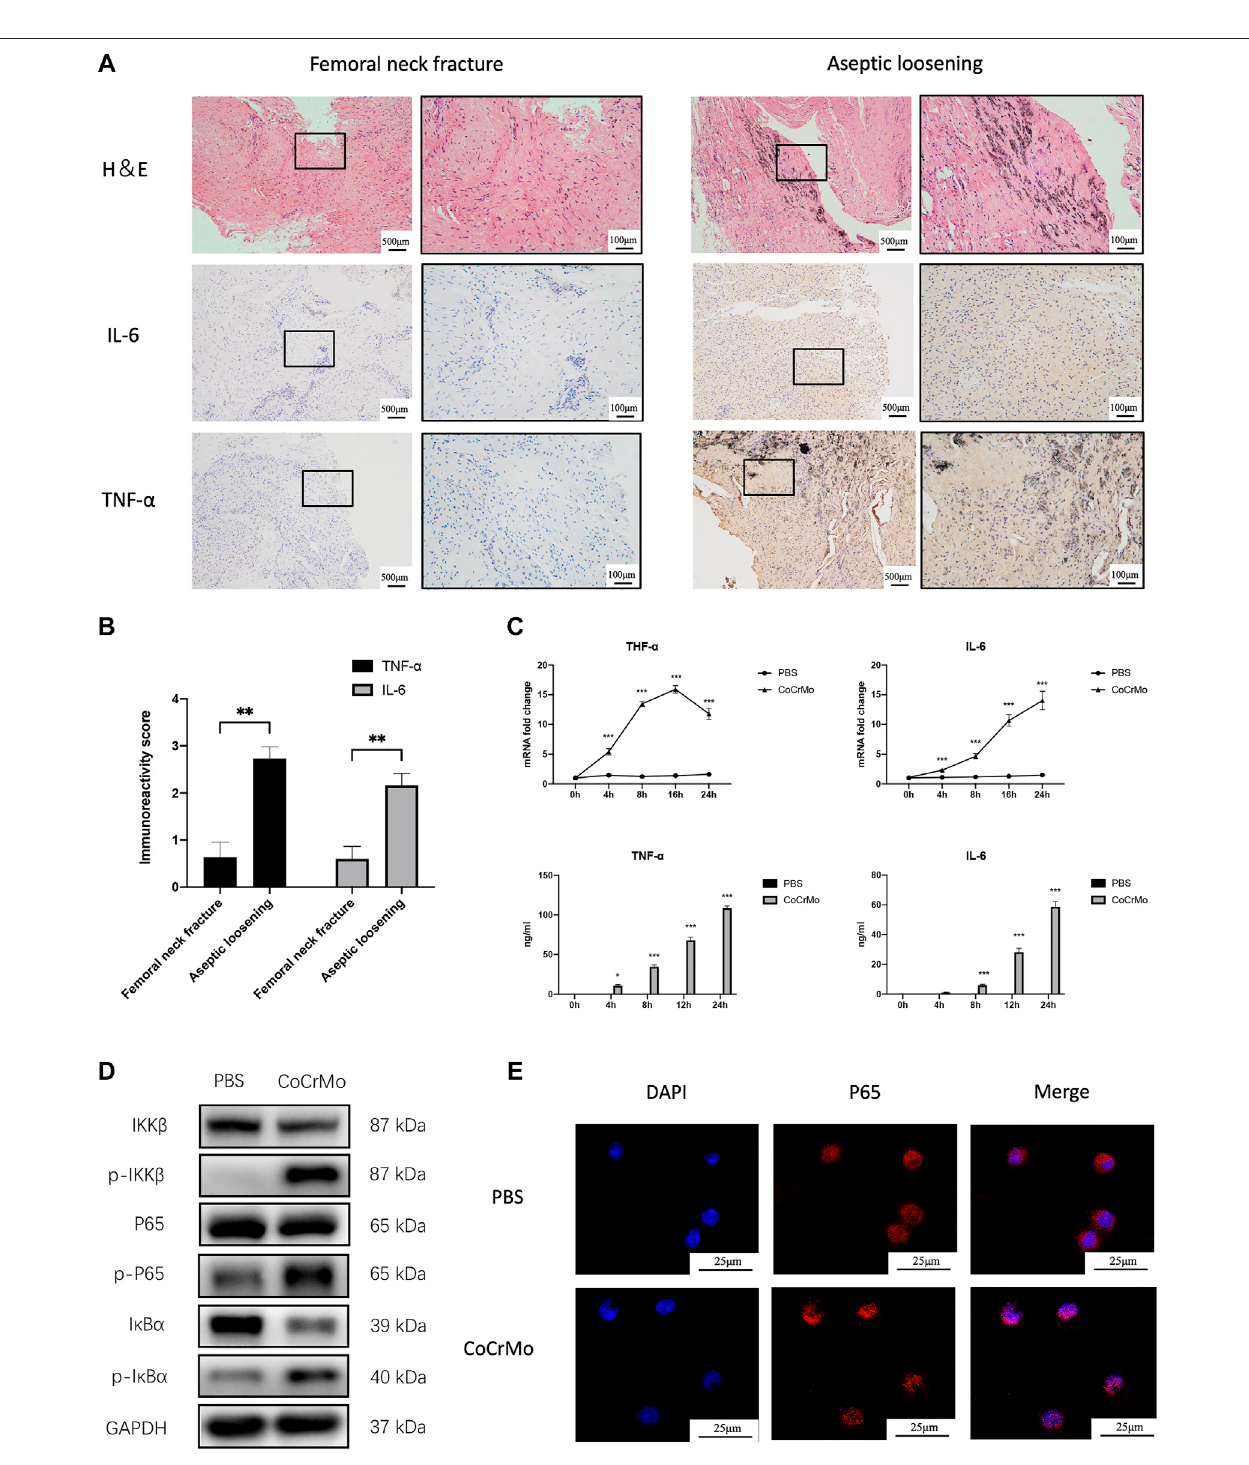
FIGURE2| CoCrMowearparticlesinducedTNF- α andIL-6expression via NF- κ Bsignalingactivation. (A) H&EstainingandimmunohistochemicalstainingofTNF- α and IL-6 in synovial membranes offour patients who were diagnosed with aseptic implant loosening and another four patients who were diagnosed with femoral neck fracture. (B) SemiquantitativeassessmentsofthestainingintensityusingBresalier ’ ssemiquantitativescoringsystemfortheasepticimplantlooseninggroupandfemoral neck fracture group. (C) mRNA expressions and secretions of TNF- α and IL-6 by BMDMs were signi fi cantly higher than the PBS group after being stimulated by CoCrMo wear particles. (D) Increased protein concentrations of p-IKK β , p-p65 and p-I κ B α in BMDMs following CoCrMo particle stimulation. (E) p65 protein (red) translocates from the cytoplasm into the nucleus (blue) of BMDMs after being stimulated by CoCrMo wear particles. * indicates p < 0.05, ** indicates p < 0.01, and *** indicates p < 0.001 when compared with the control group at the same time